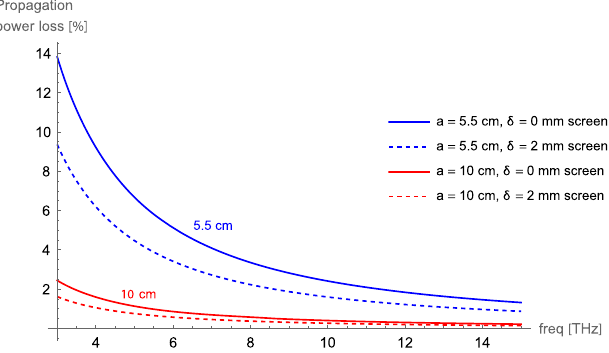
FIG. 9. Propagation loss is shown as a function of frequency for two iris radii ( a ¼ 5 . 5 or 10 cm), two screen thicknesses (0 or 2 mm) and over a distance of 150 m to reach the near experimental hall in LCLS. The iris-line period is b ¼ 30 cm and the effect of thickness is found from the mode-matching analysis and then used to refine Vainstein ’ s model (assuming that it is the same effect for both cases, namely Δ Im ½ β 0 (cid:2) = Im ½ β (cid:2) ≅ − 33 . 9% ). The larger radius is recommended, if mechanically feasible and does not have a considerable transient at the line ’ s